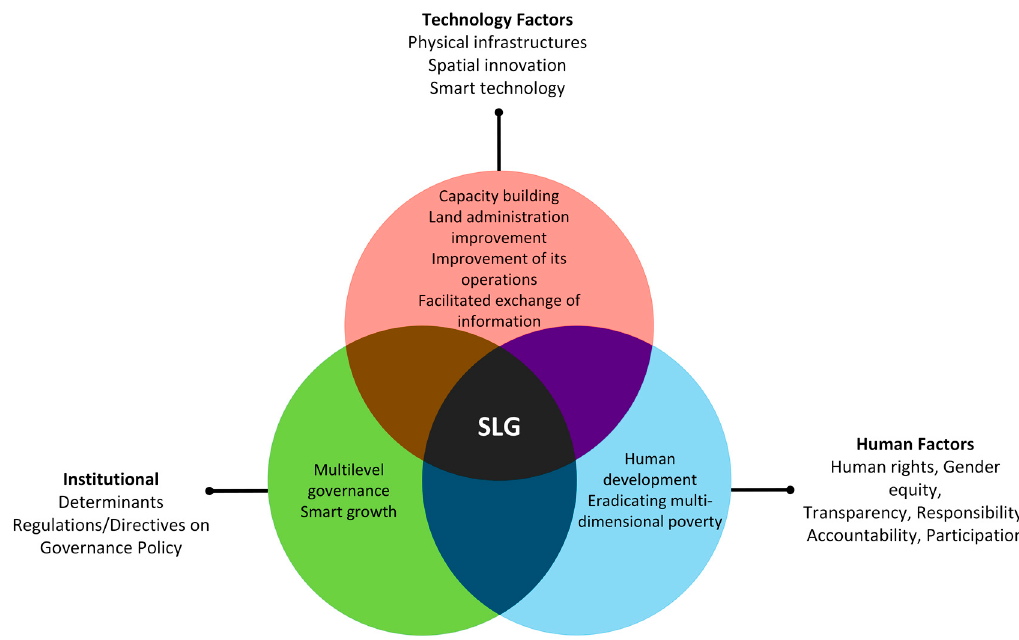
Figure 2. Conceptual model of SLG.